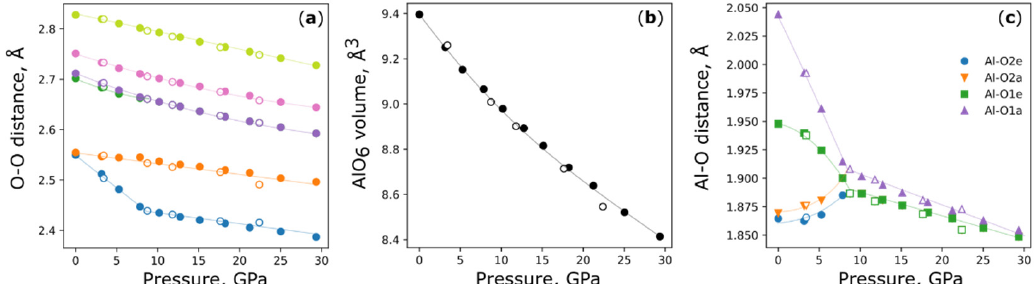
Figure 6. ( a ) Evolution of the shortest oxygen-oxygen distances with pressure, blue is hydrogen bond, other curves are O-O distances within the AlO 6 octahedron; ( b ) pressure-dependent evolution of the AlO 6 octahedron volume; ( c ) evolution of Al-O bonds within the AlO 6 polyhedra (see Figure 2 for atoms assignment). Lines are guides for the eye and error bars are smaller than the marker sizes.